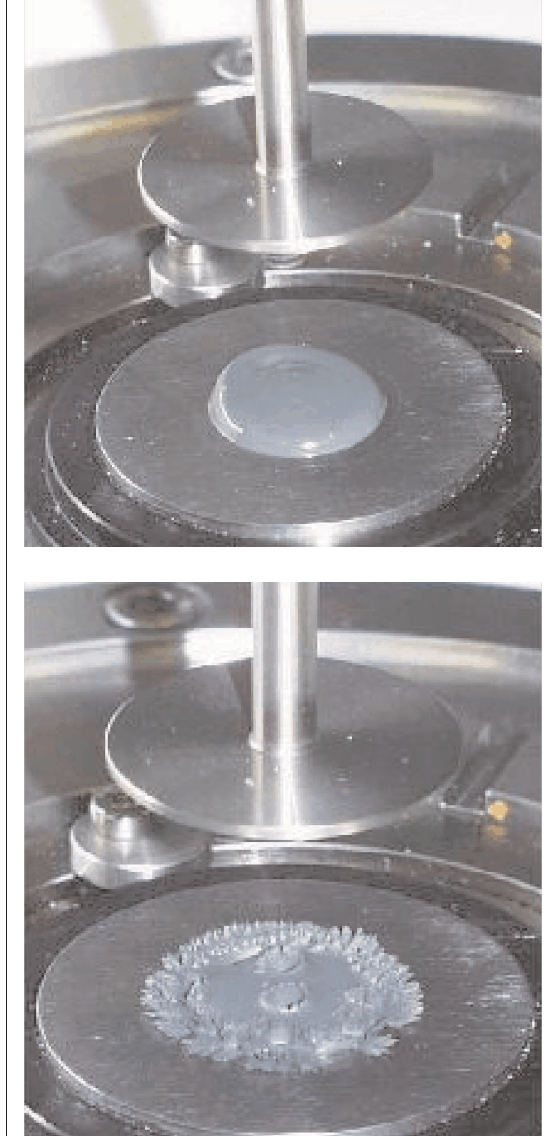
Figure 10 (left above): Parallel-plate sensor with a MRF showing the quasi gel character (Region II.). Figure 11 (right above): Parallel-plate sensor with a MRF exceeding Region II (from Region II. to Region III.). Figure 12 (left below): Parallel-plate sensor with a MRF showing consolidation to rigid needles oriented to the outer, disconnected magnetic bridge between cover and highly permeable base ring which is not yet demagnetized (Region